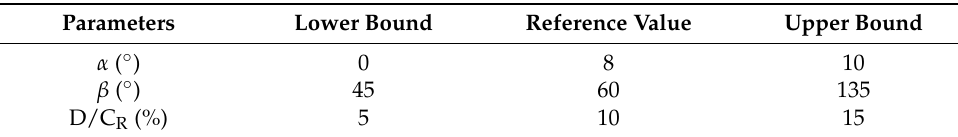
Table 3. Ranges of parameters tested in the parametric study.